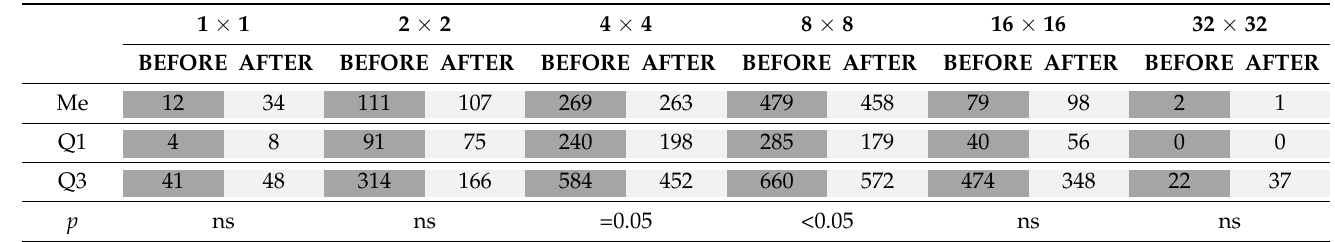
Table 2. The number of blocks with sides of 1 × 1, 2 × 2, 4 × 4, 8 × 8, 16 × 16 and 32 × 32 pixels, resulting from the quadtree decomposition of the left cheek image recorded with a cross-polarization filter before the series of treatments (BEFORE) and after the series of treatments (PO). Me = median; Q1 = lower quartile; Q3 = upper quartile; p = level of statistical significance; ns = no significance.